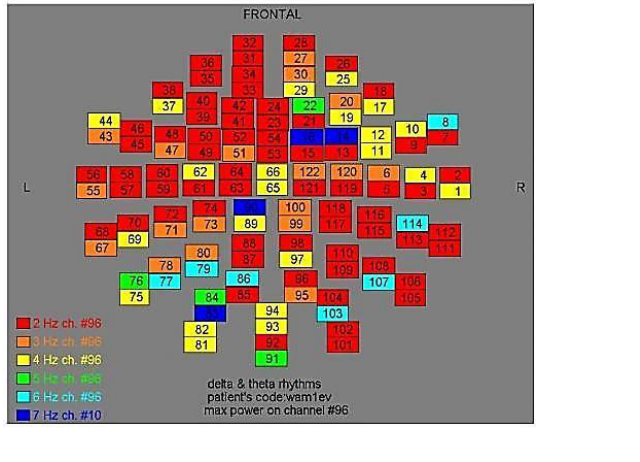
Figure 8. Dominant frequency color mapping for patient #7, before ( a ) and after ( b ) magnetic stimulation.